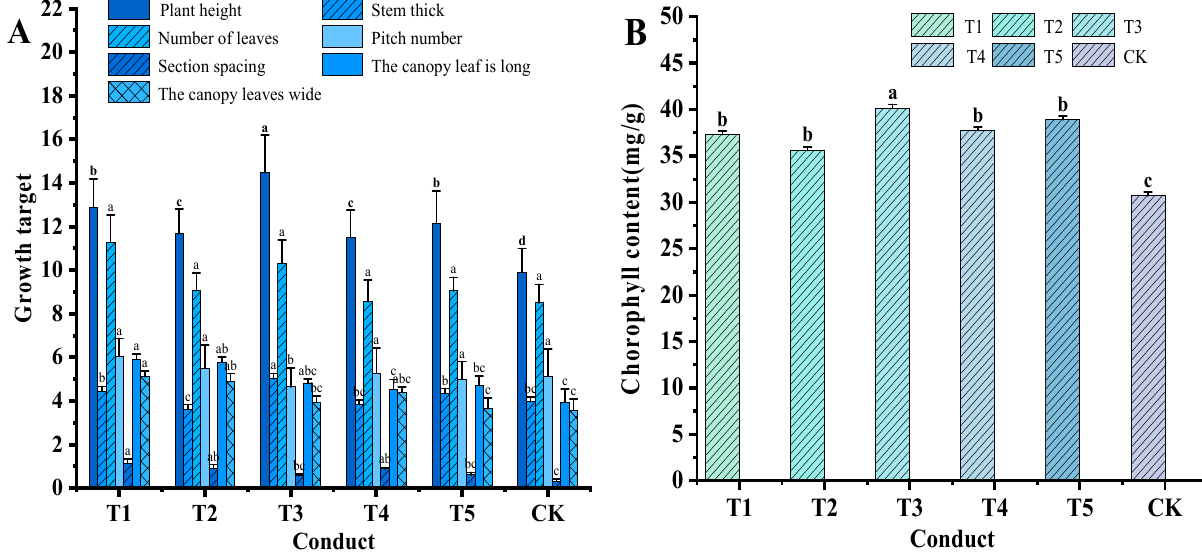
Figure 4. Chlorophyll content and growth index of muskmelon leaves under different light matter treatment. A is the growth indicator; B is the chlorophyll content. Different lowercase letters indicate significant differences in the growth index and chlorophyll content between different treatments in the same period ( p < 0.05).